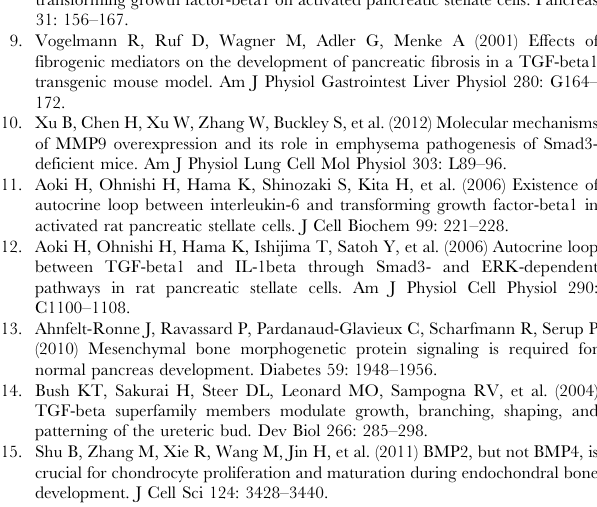
Figure S1 Endocrine function in wild-type and BMPR2 + / 2 mice under chronic pancreatitis induction. plasma collected after four weeks of cerulein injections. (B) IPGTT was performed utilizing an AccuChek glucometer from the mouse plasma collected at indicated time points after glucose injection.